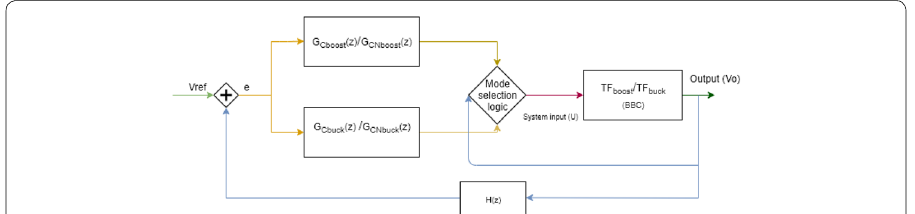
Fig. 5 Digital closed-loop control model of bidirectional buck–boost converter with PID and PIDN control